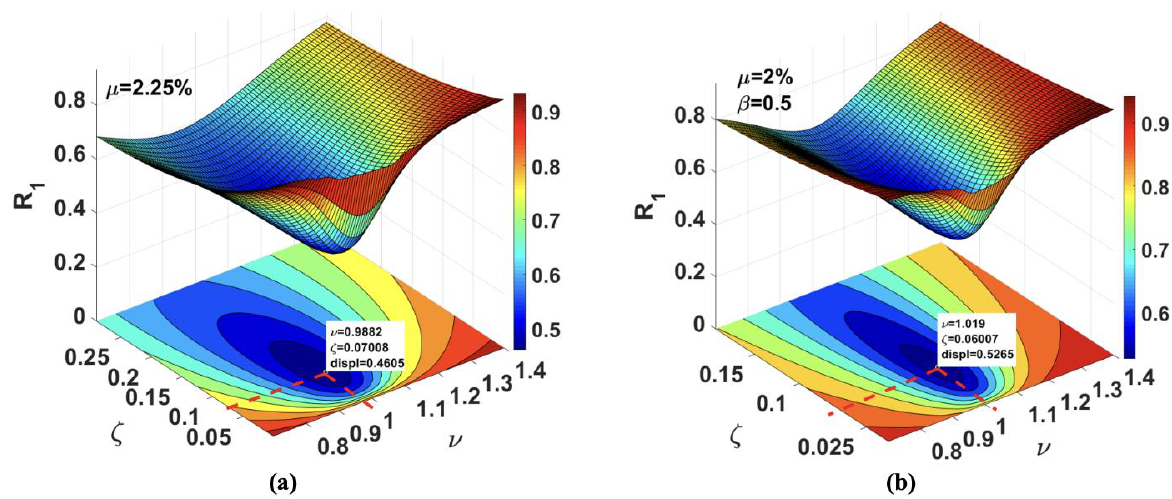
Figure 11. Optimization for minimizing RMS displacement at the top floor, under variable frequency excitation: ( a ) TMD and ( b ) TMDI.